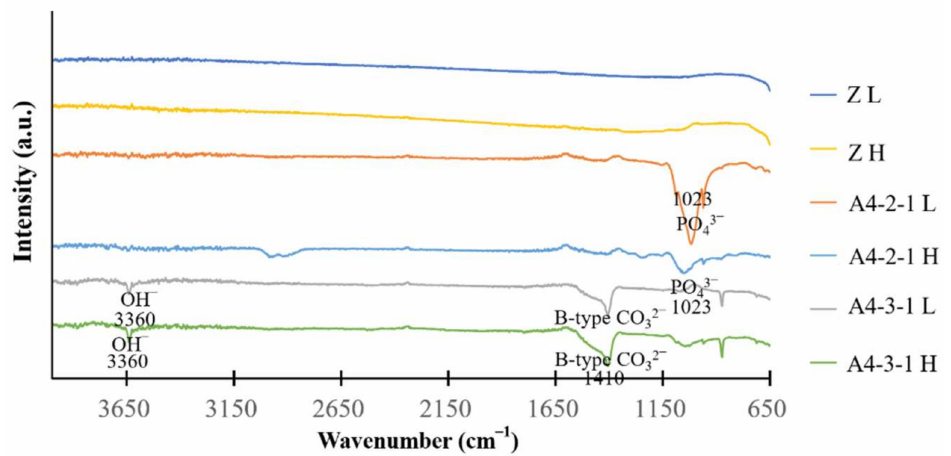
Figure 13. Fourier-transform infrared spectroscopy (FTIR). Functional groups of sintering samples were analyzed via FTIR.